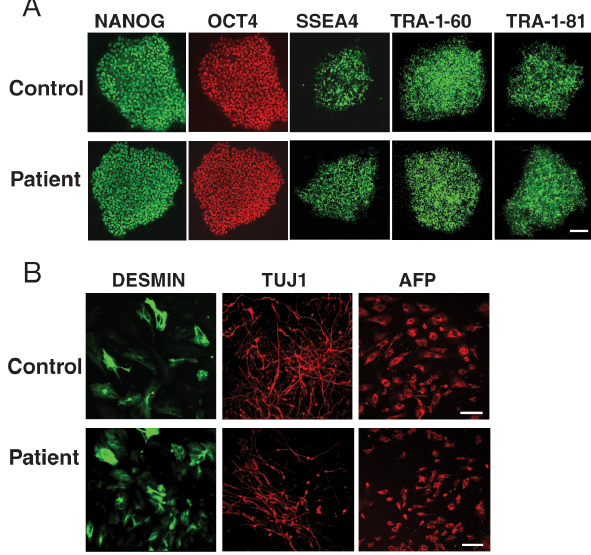
Figure 2. Verification of the pluripotency of the iPSC lines with the TDP-43 A90V mutation. ( A ) Fluorescence microscopy images of the expression of the pluripotency markers NANOG, OCT4, SSEA4, TRA- 1-60, and TRA-1-81 in control (37L25) and patient (36L10) iPSC lines. Scale bar: 20 m m. ( B ) All iPSC lines differentiated into cells of the three germ layers, as shown by expression of desmin (mesoderm), TUJ1 (ectoderm), and alpha-fetoprotein (AFP, endoderm). These analyses indicate iPSC lines generated here are indeed pluripotent. Scale bar: 20 m m.